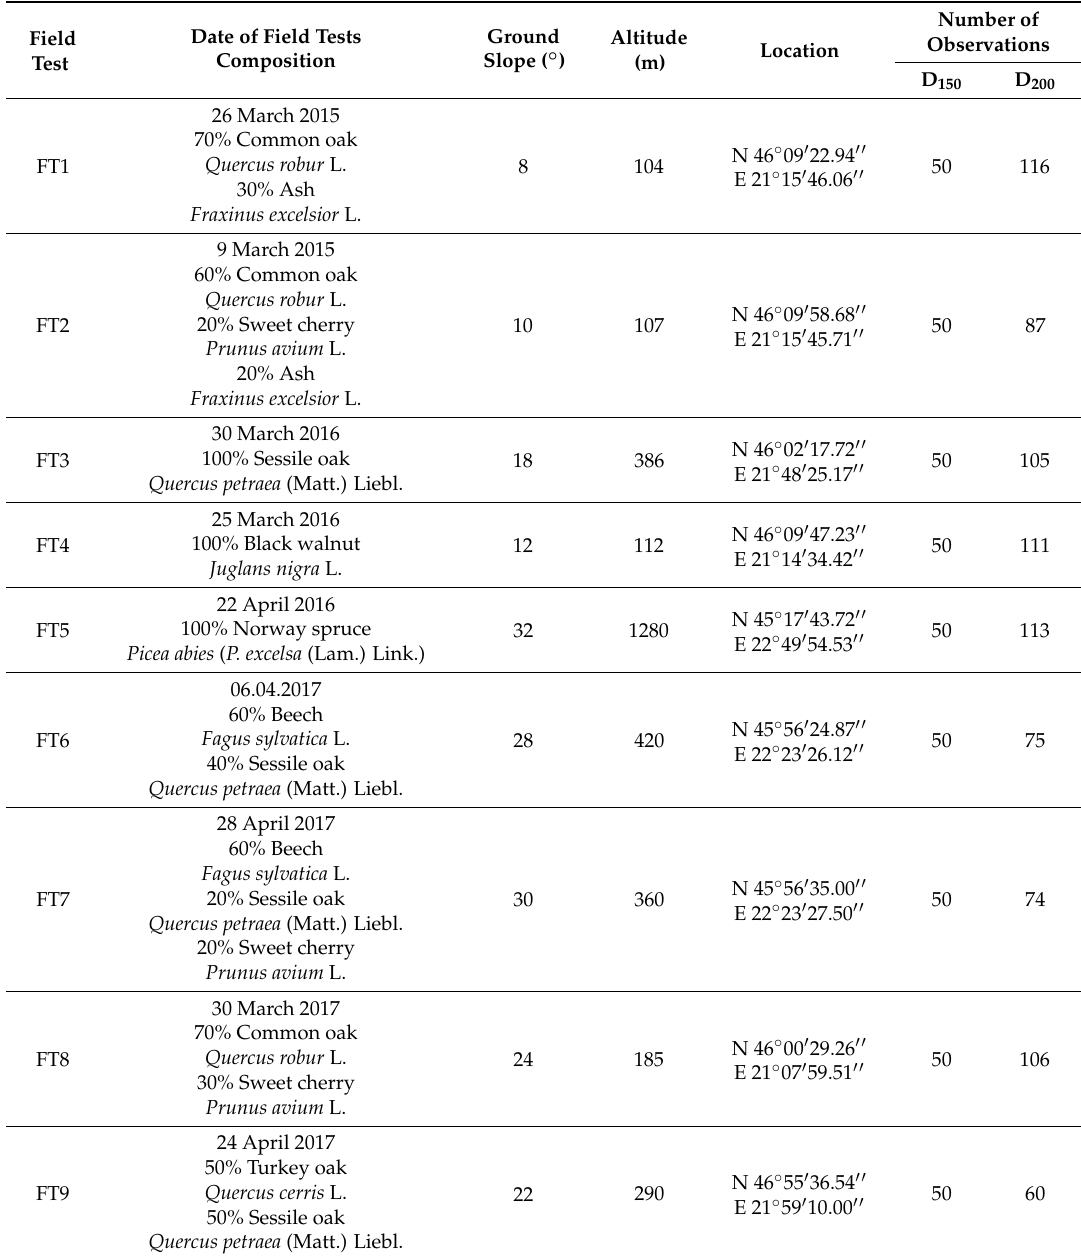
Table 1. Basic description of the field